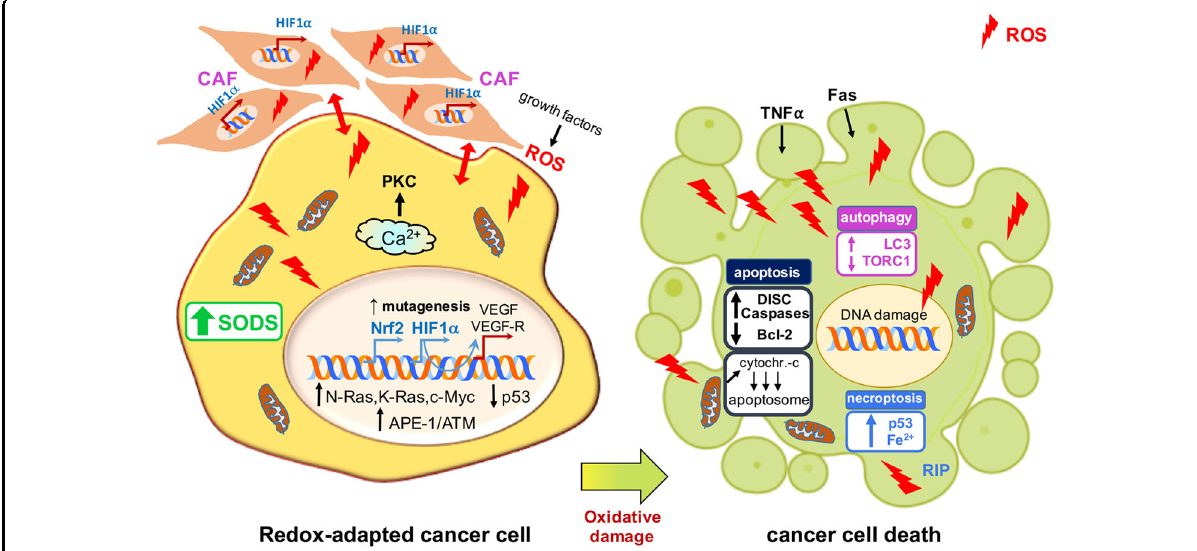
Fig. 2 The three types of programmed cell death induced by elevated ROS levels in cancer cells. ROS, in response to death-inducing ligands (TNF α and Fas), enhance the assembly of DISCs and the activation of effector caspases and reduce Bcl-2 activity or, as a consequence of increased permeability of mitochondrial PTPs, stimulate the intracytoplasmic release of cytochrome c, which interacts with Apaf-1 and procaspases and forms the apoptosome (apoptosis). ROS can also inhibit the negative regulators of autophagy (TORC1) and increase the formation of LC3-dependent autophagosomes (autophagy). Finally, high levels of ROS, induced by several receptor-interacting protein kinases (RIPs), increase p53 expression, which increases ROS levels via a mechanism that depends on intracellular iron